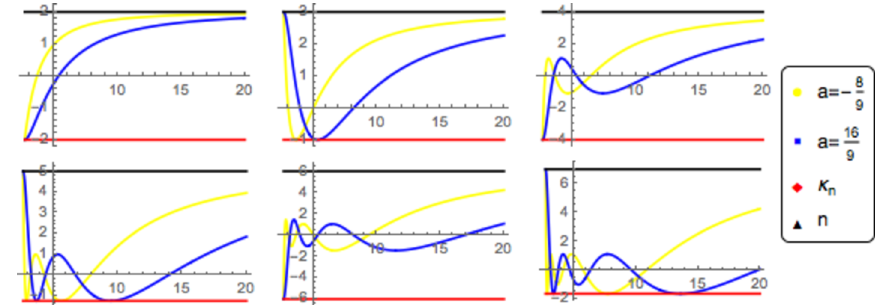
Figure 2. β n /β 1 vs s 1 for n = 2 , 3 , 4 and n = 5 , 6 , 7 , from left to right. The above plots show that the Rogosinksi bounds are respected the amplitude for the full range of a namely − 8